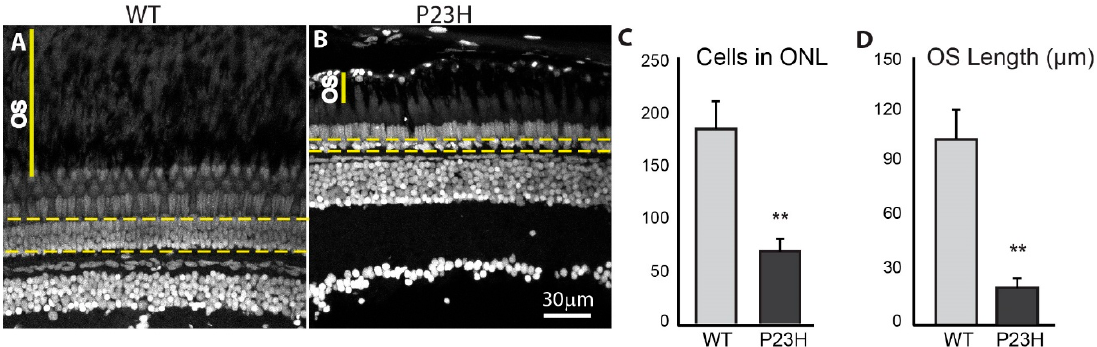
Figure 4. Photoreceptor loss in the P23H transgenic zebrafish. DAPI label of adult retina sections. The yellow dotted lines encompass nuclei in the ONL counted to assess photoreceptor loss. OS indicates the space between photoreceptor myoids and retinal pigmented epithelium. The number of cells in the ONL is almost three times greater in the WT ( A ) than in the P23H mutant ( B ), which usually shows a single irregular layer of nuclei. ( C ) Quantification of photoreceptor counts in WT and P23H transgenic (n = 6 fish per genotype; error bars are ± SD; ** p < 0.01). ( D ) Quantification of OS length in WT and P23H transgenic (n = 6 fish per genotype; error bars are ± SD; ** p < 0.01). Scale bar in B applies to A and B.